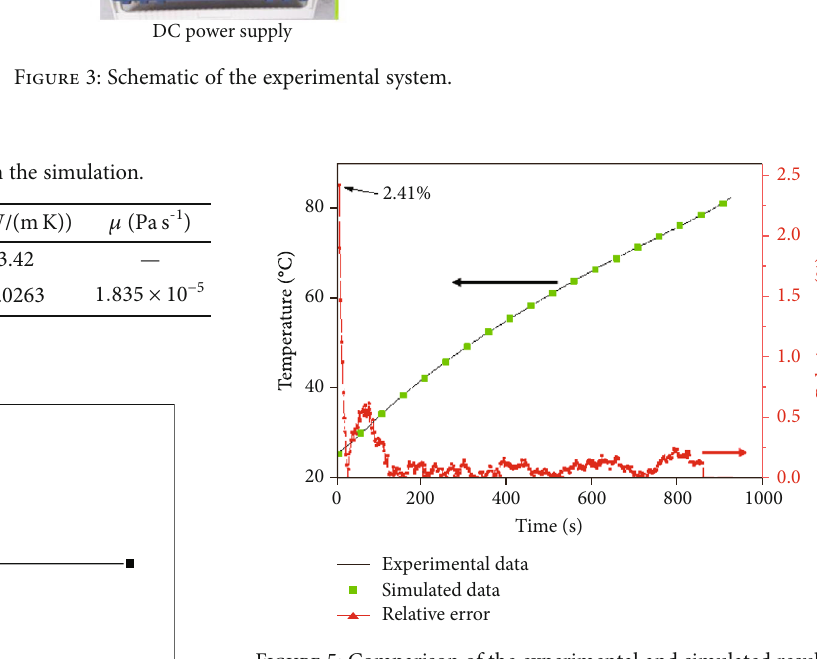
Figure 5: Comparison of the experimental and simulated results of a single